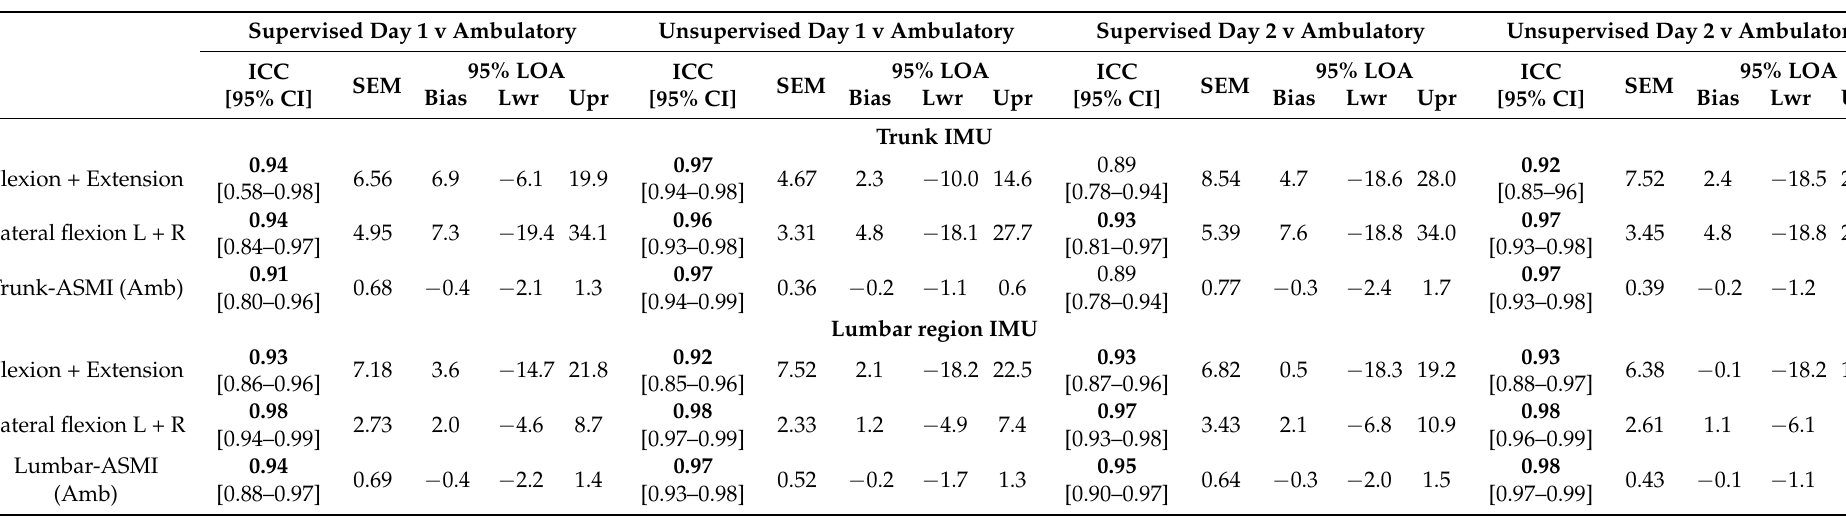
Table 6. Test-retest reliability and agreement of full-arc movement measurements and composite –ASMI (Amb) scores under laboratory and ambulatory